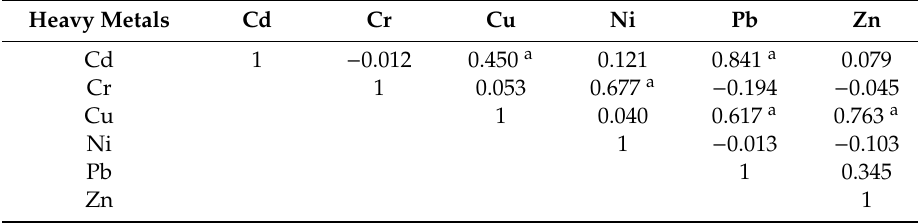
Table 9. Pearson correlation coe ffi cients for heavy metals (n =